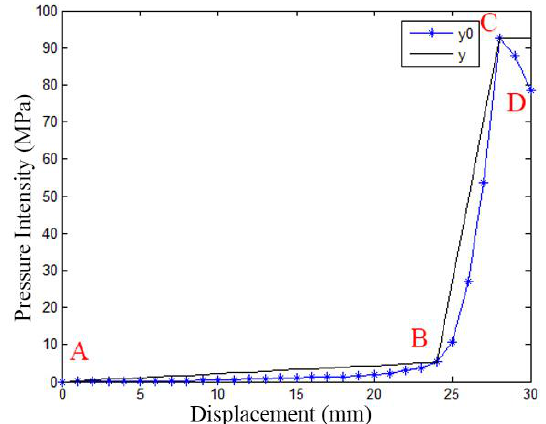
Figure 7. Pressure versus displacement in a single pouch at 30 °C: pre-compression stage (AB), compression stage (BC) and extrusion stage (CD).